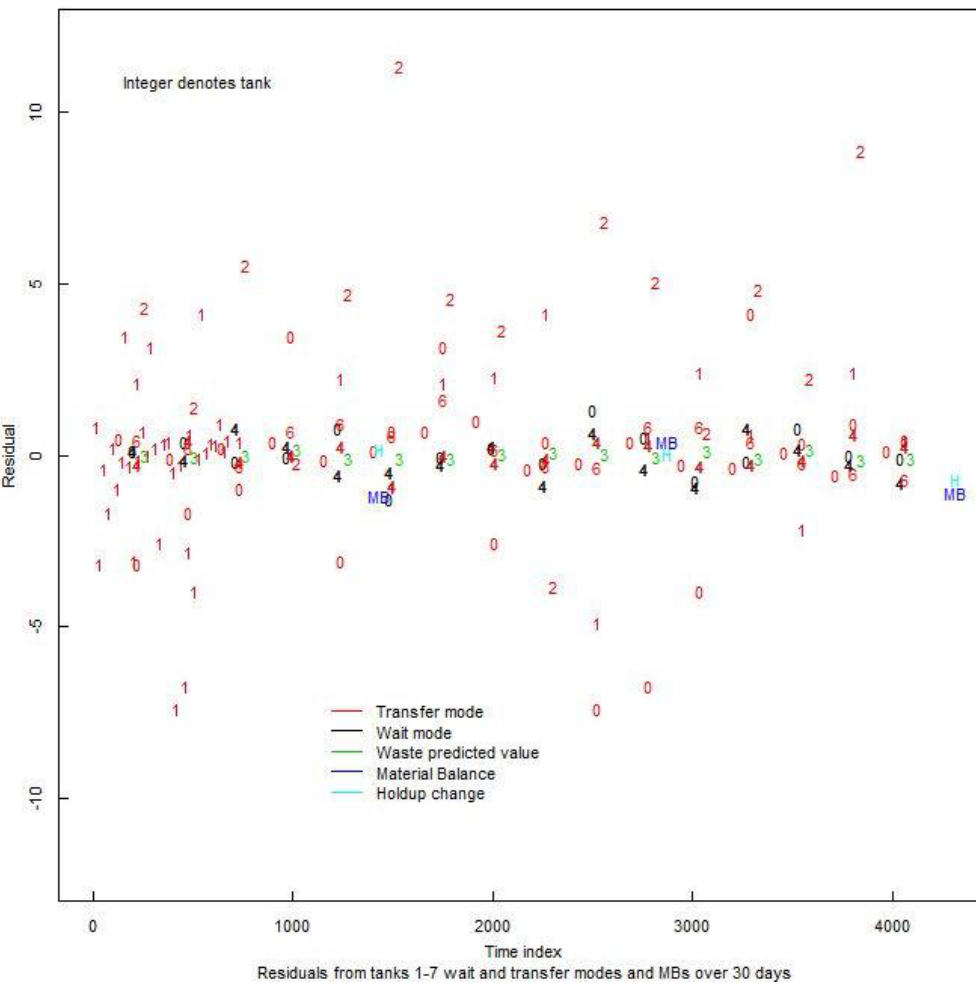
Figure 8. Residuals from PM and NMA for the 7-tank MBA in an aqueous facility. The PM residuals occur at the end of each wait event and after each transfer event. The NMA residuals are the usual MBs every 10